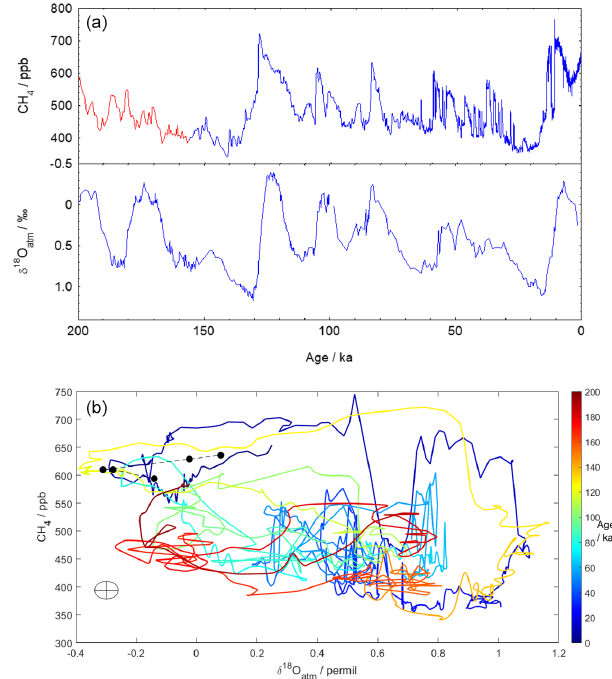
Figure 8. Reference data for CH 4 and δ 18 O atm (Extier et al., 2018) over the last 200kyr. Data are all on the AICC2012 age model. (a) The two datasets as time series. CH 4 to 156ka in blue (Köh- ler et al., 2017) and beyond 156ka in red (Loulergue et al., 2008). (b) Cross plot of CH 4 and δ 18 O atm reference data for the period 0–200ka. The colour bar indicates the age of the sample. The com- bined uncertainty is shown by the grey ellipse/cross. An alternative visualisation of panel (b) is provided in Fig. S5. The black dots are data from Skytrain Ice Rise from 621.5 to 627.3m (following the dashed line clockwise).